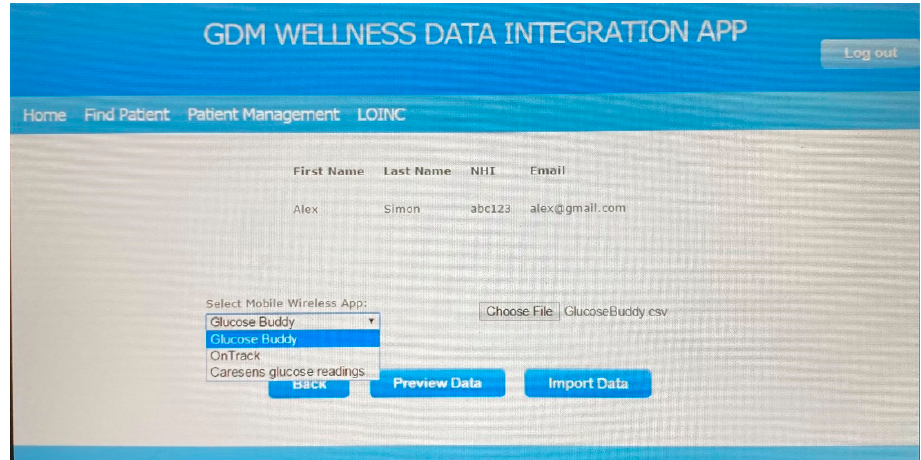
Figure 5. Downloading patient data.